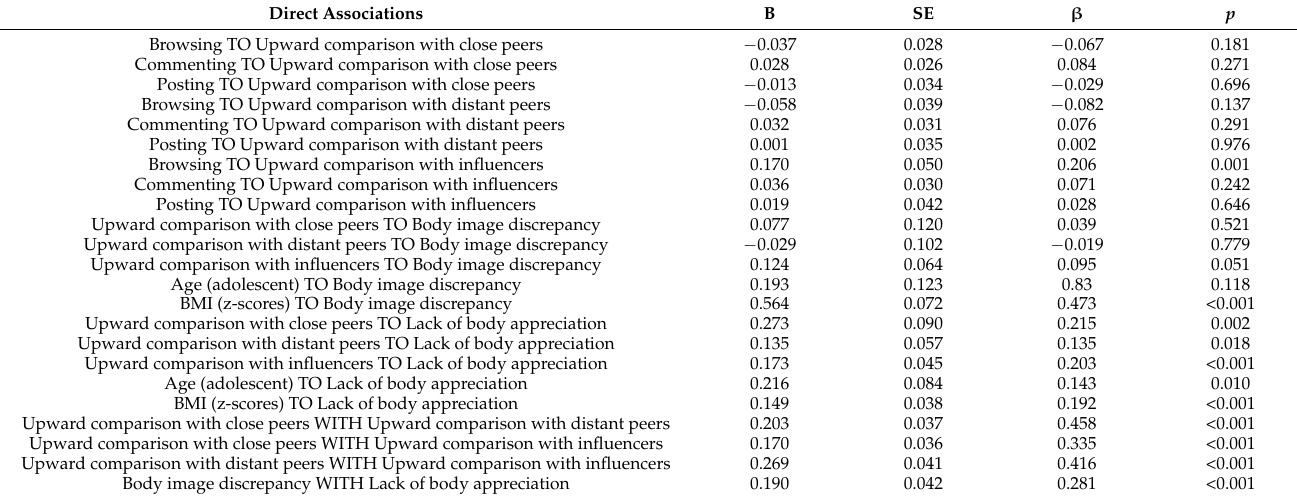
Table 3. Path and correlation coefficients for all direct associations in the final mediation model.